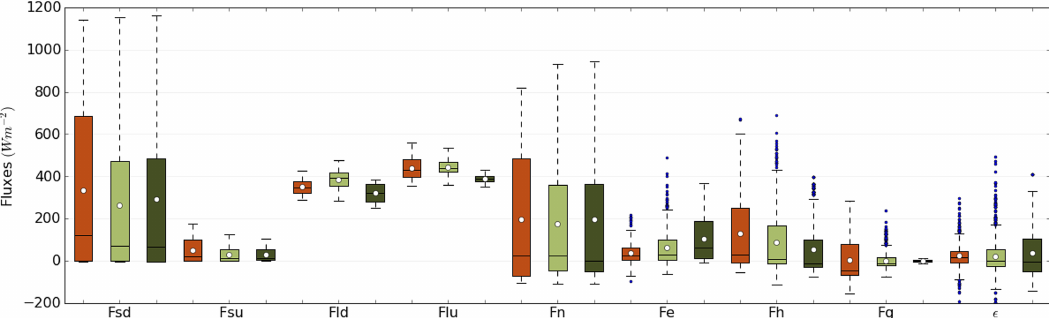
Figure 4. Box plot of energy fluxes for Mediterranean woodlands (MW, red), temperate woodlands (TW, light green) and temperate forests (TF, dark green). Energy fluxes are incoming shortwave radiation (Fsd), reflected shortwave radiation (Fsu), downward longwave radiation (Fld), emitted longwave radiation (Flu), net radiation (Fn), latent heat flux (Fe), sensible heat flux (Fh), ground heat flux (Fg) and energy imbalance ( ε) during the background period BGH (2–6 January 2014). The box extends from the lower to upper quartile values of the data, with a line at the median. The mean value is indicated with a dot. The whiskers extend from the box to show the range of the data. Flier points (outliers, blue dots) are those past the end of the whiskers.